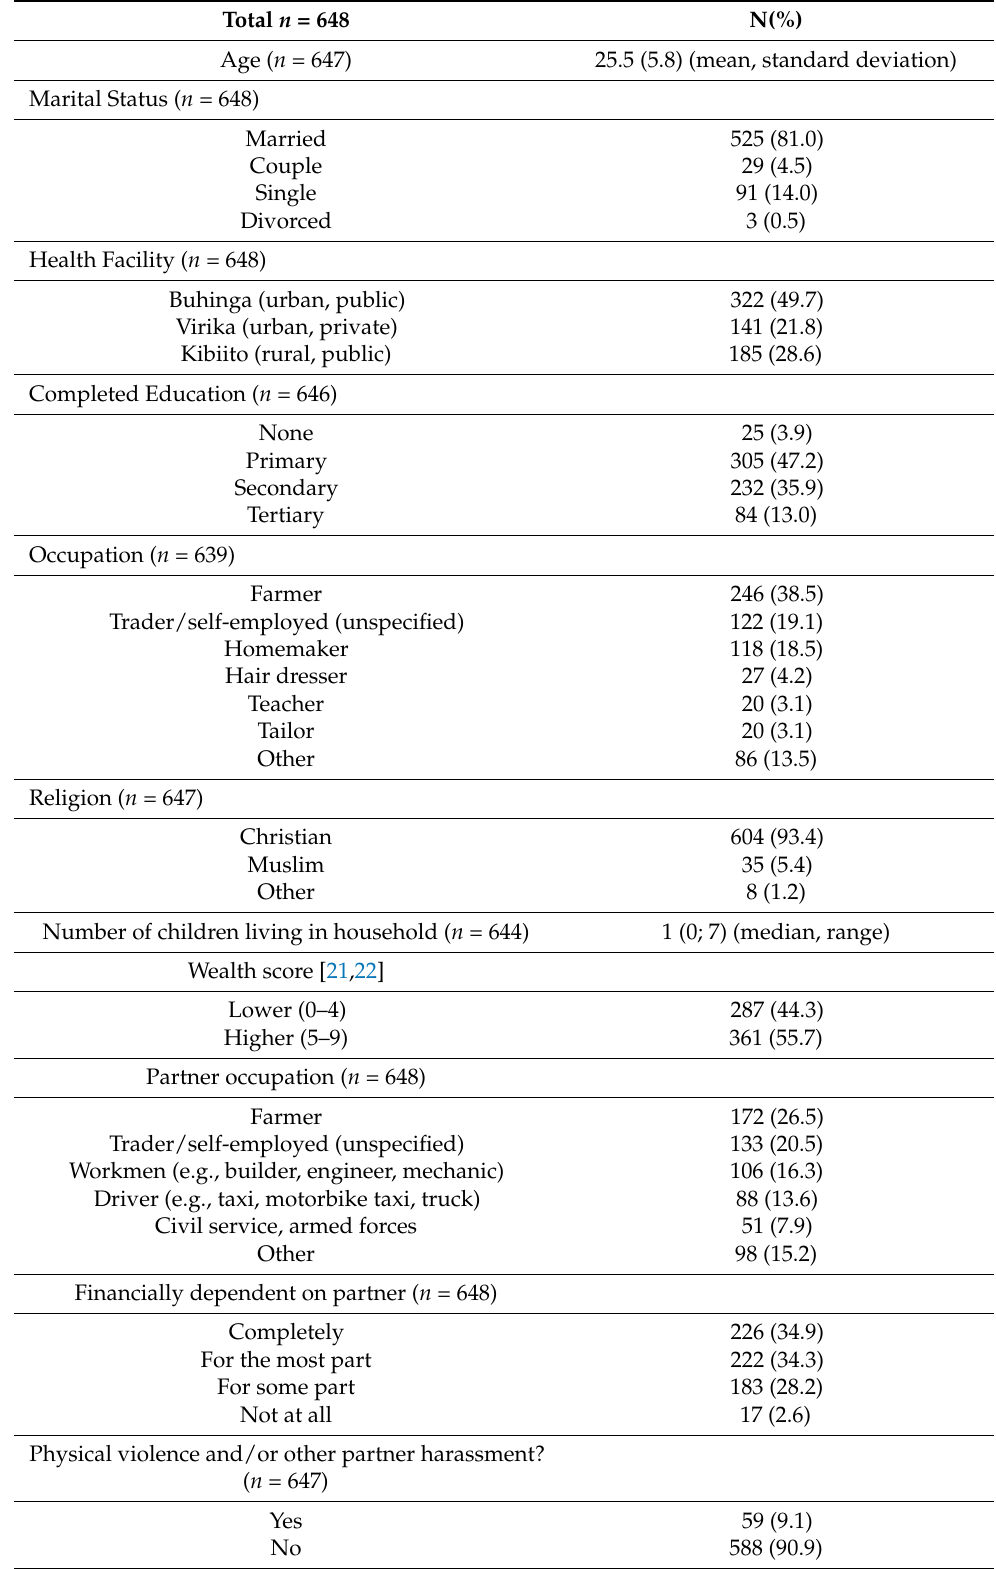
Table 1. Sociodemographic characteristics of the women and their